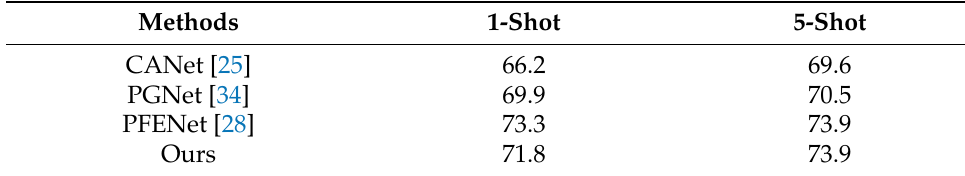
Figure 9. PFMNet qualitative results of one-shot and five-shot. The leftmost support of each row is used to generate one-shot results. Table 5. Average FB-IoU results on ResNet-50 of PASCAL-5 i